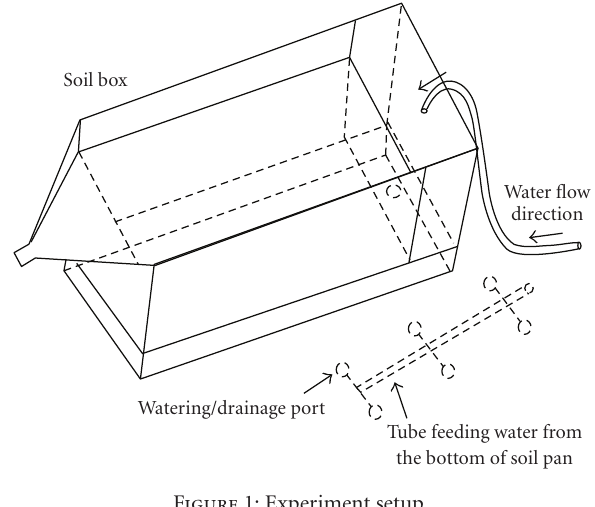
Figure 1: Experiment setup. Table 1: List of experiment